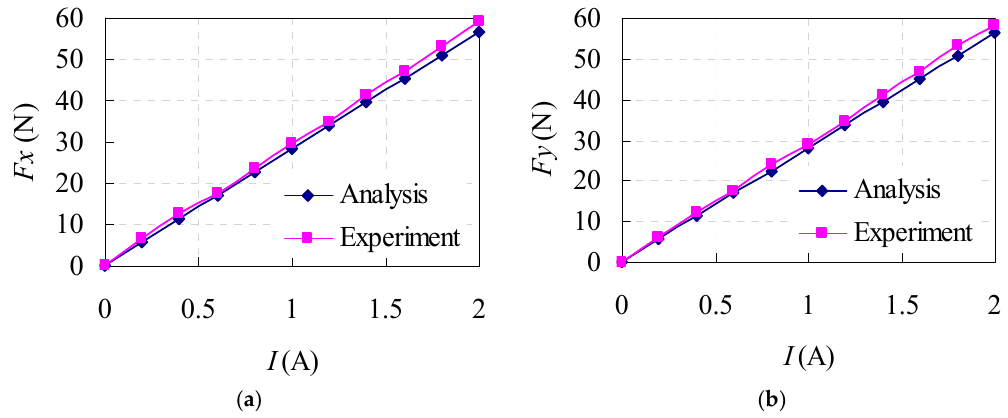
Figure 13. Force characteristics versus current: ( a ) force in the x direction; ( b ) force in the y direction.